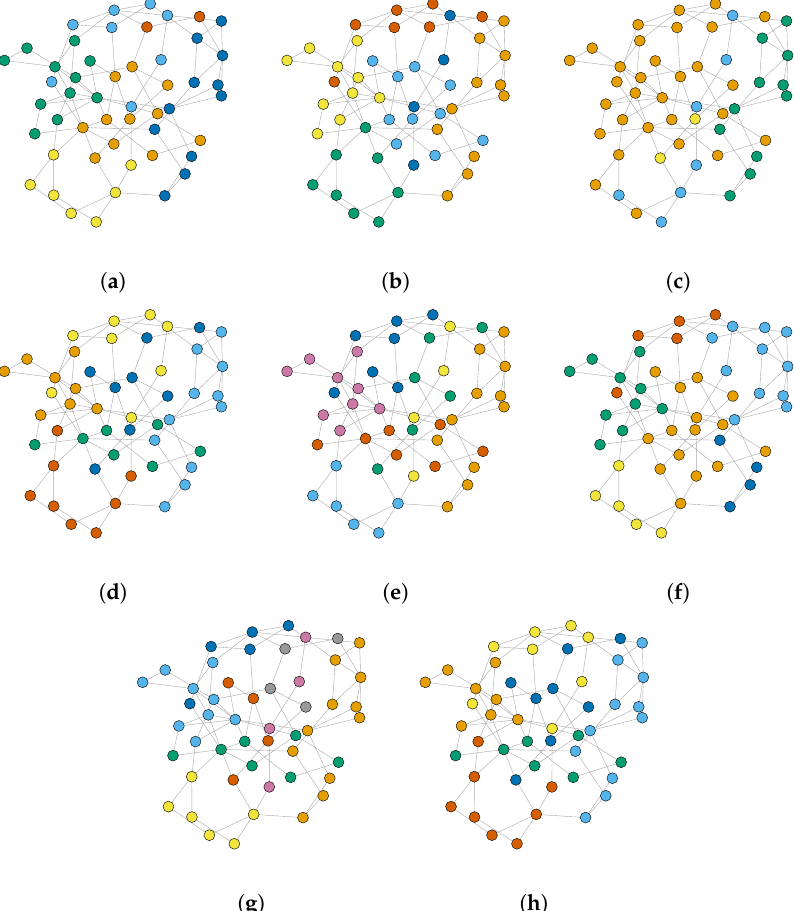
Figure 2. Comparison of the community detection of the described algorithms over a example graph with 50 nodes that presents community structure. ( a ) edge-betweenness; ( b ) fast-greedy; ( c ) label propagation; ( d ) Multi-Level; ( e ) Spinglass; ( f ) Walktrap; ( g ) Infomap; ( h )